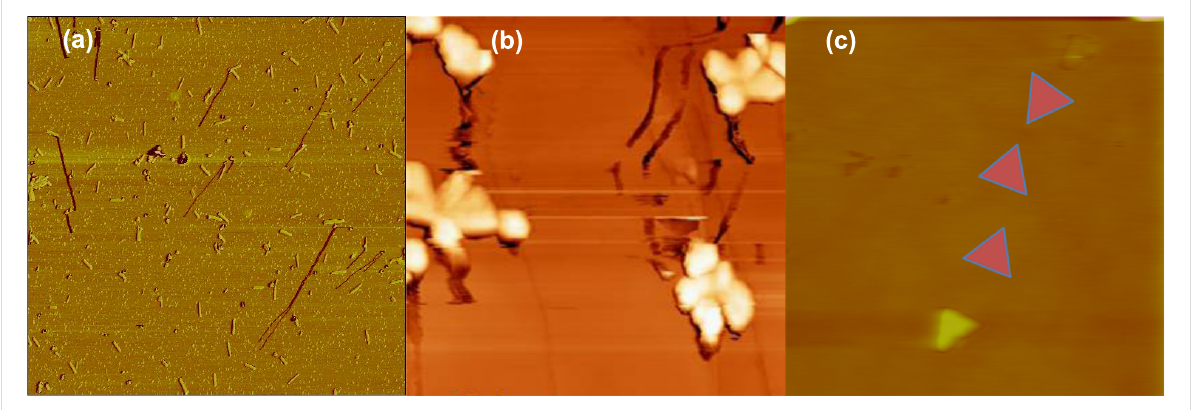
Figure 4: AFM images of nanocluster movement during their manipulation (a) gold nanorods deposited onto silicon wafer, scan size: 12 µm; (b) anti- mony islands on HOPG, scan size: 1.5 µm; (c) Au nanotriangles on silicon wafer. Middle triangles have been intentionally colored in to illustrate the trajectory of the Au nanoparticles during manipulation, scan size: 5 µm.